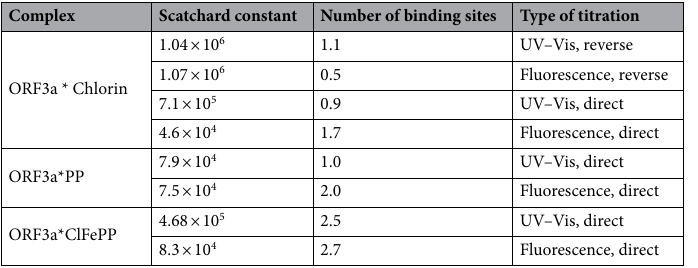
Table 2. The affinity and number of binding sites for ORF3a and its complexes with porphyrins in relation to chlorin according to the results of direct and reverse titration.